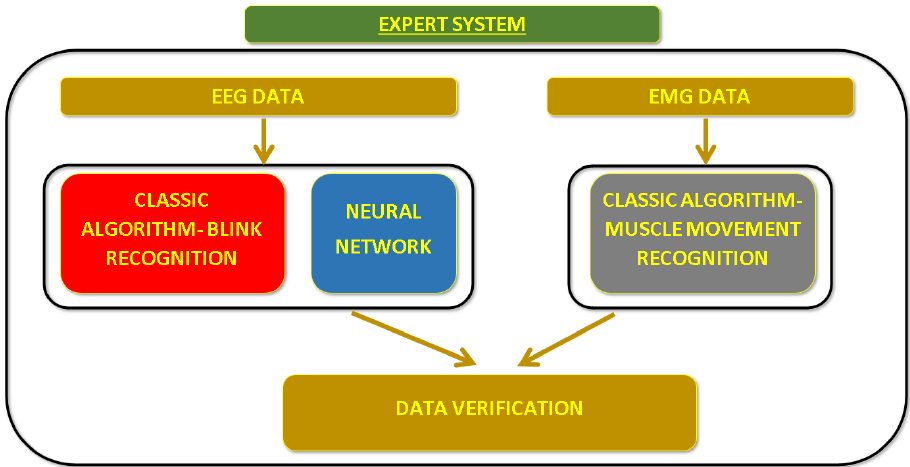
Figure 5. Presentation of the classification expert